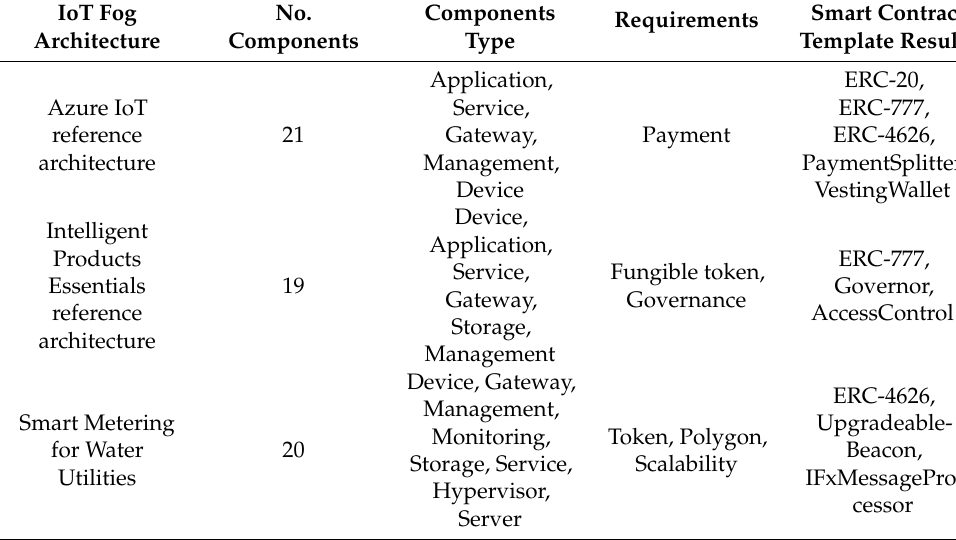
Table 2. Simulations of different recommender system